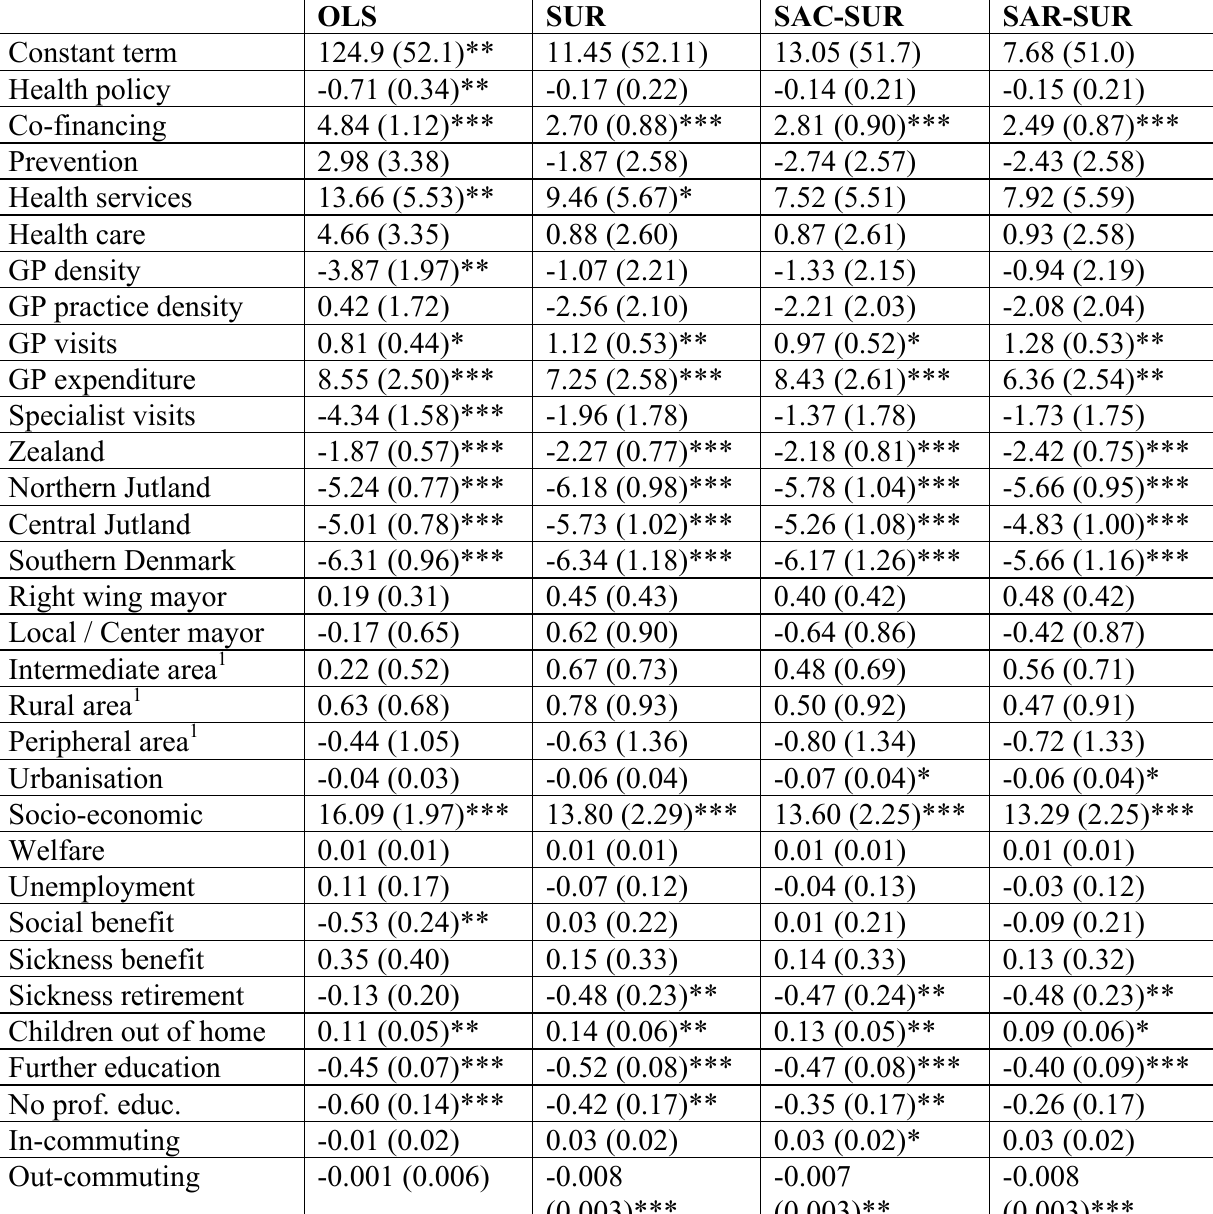
Table 2. Estimated specifications for type 2